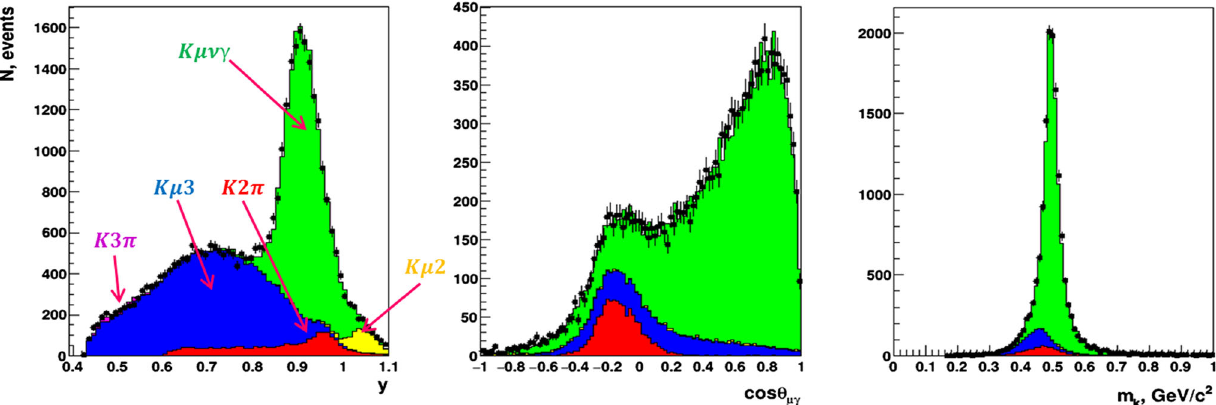
Fig. 4 Simultaneous fit in the strip 2 (0.15 < x < 0.20): y, cos θ ∗ μγ , m k . Black points with errors - data, blue - K μ 3, red - K 2 π , yellow - K μ 2, violet - K 3 π , green - signal. χ 2 / N DF = 1 . 7